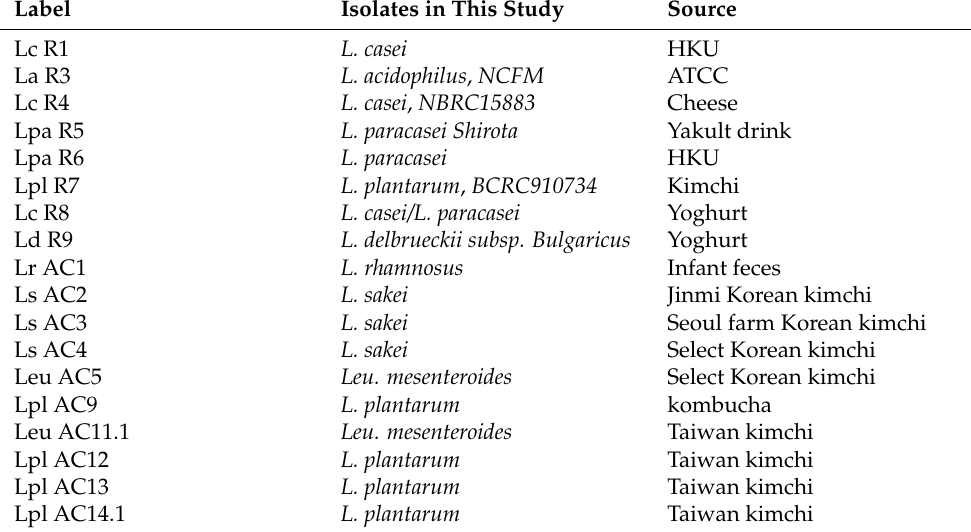
Table 1. Description of the lactic acid bacteria cultures used in this study.